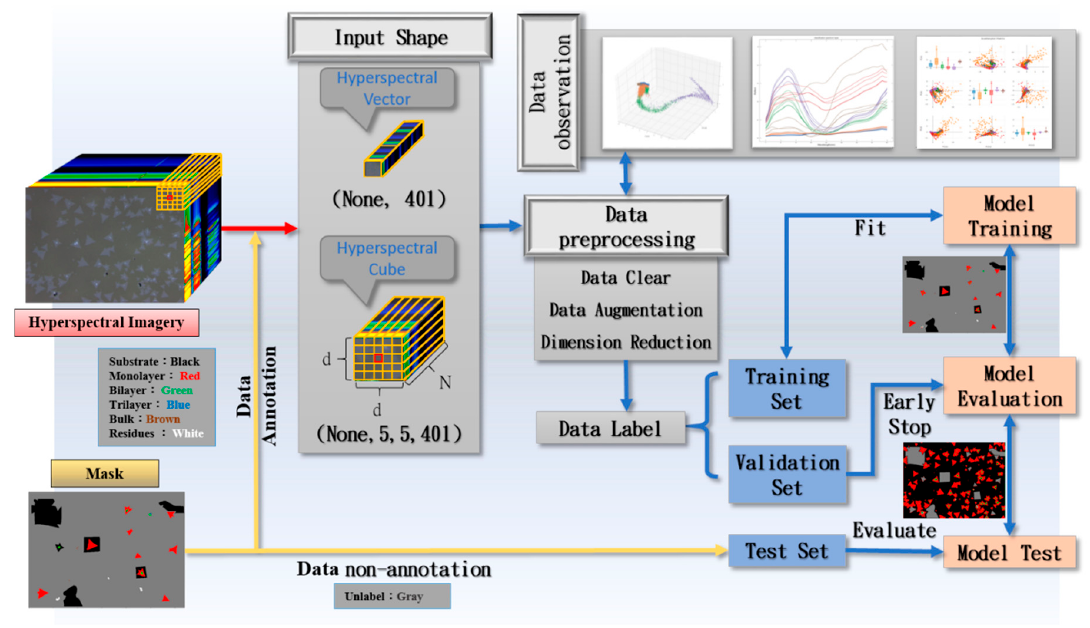
Figure 1. Data feature and label processing.